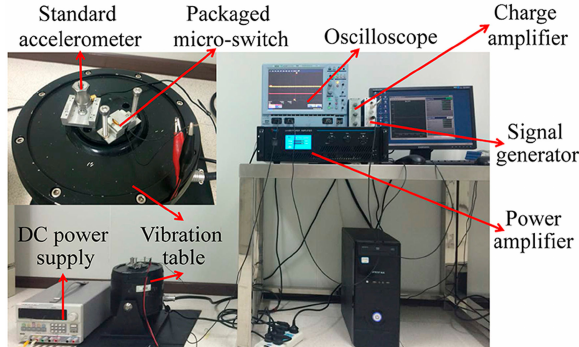
Figure 5. Experiment setup for testing the fabricated micro-switch.